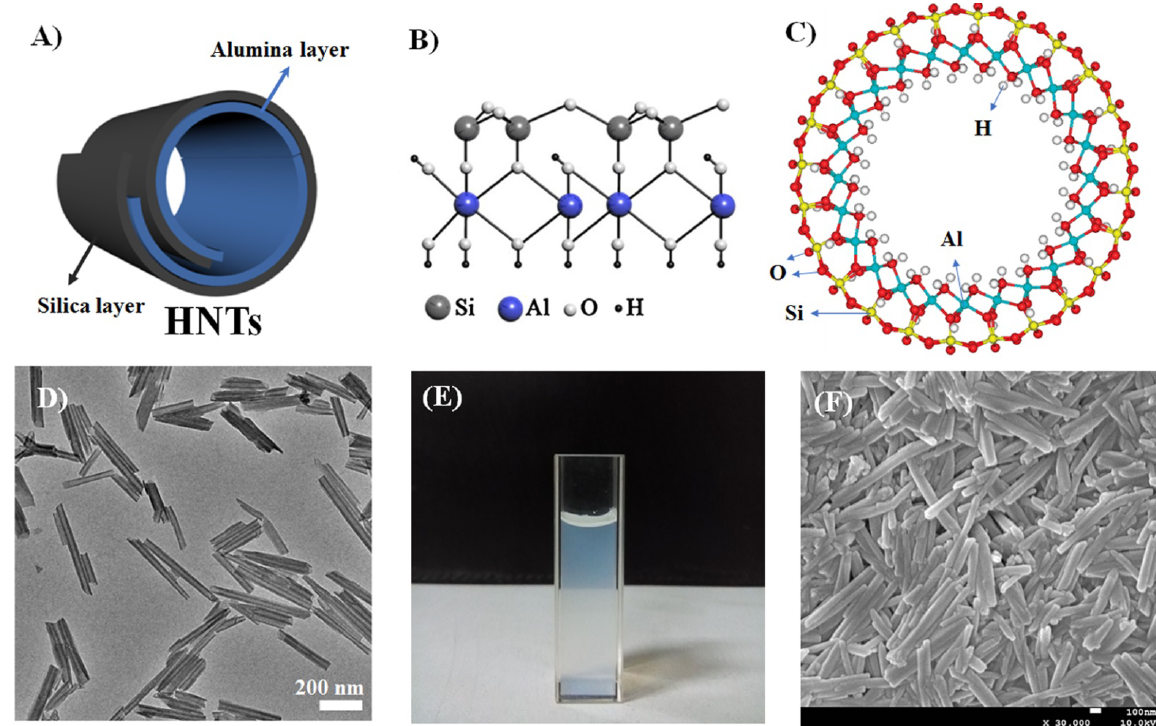
Figure 1: The structure of HNTs: A) the curly morphology of HNTs; B) schematic illustration of crystalline structure of HNTs [12]; C) cross section view of ideal single-walled HNTs calculated by Duarte et al. [13], D) the micromorphology of HNTs measured by transmission elec- tron microscopes (TEM); E) the suspension of HNTs in water; F) the micromorphology of HNTs derivative measured by scanning